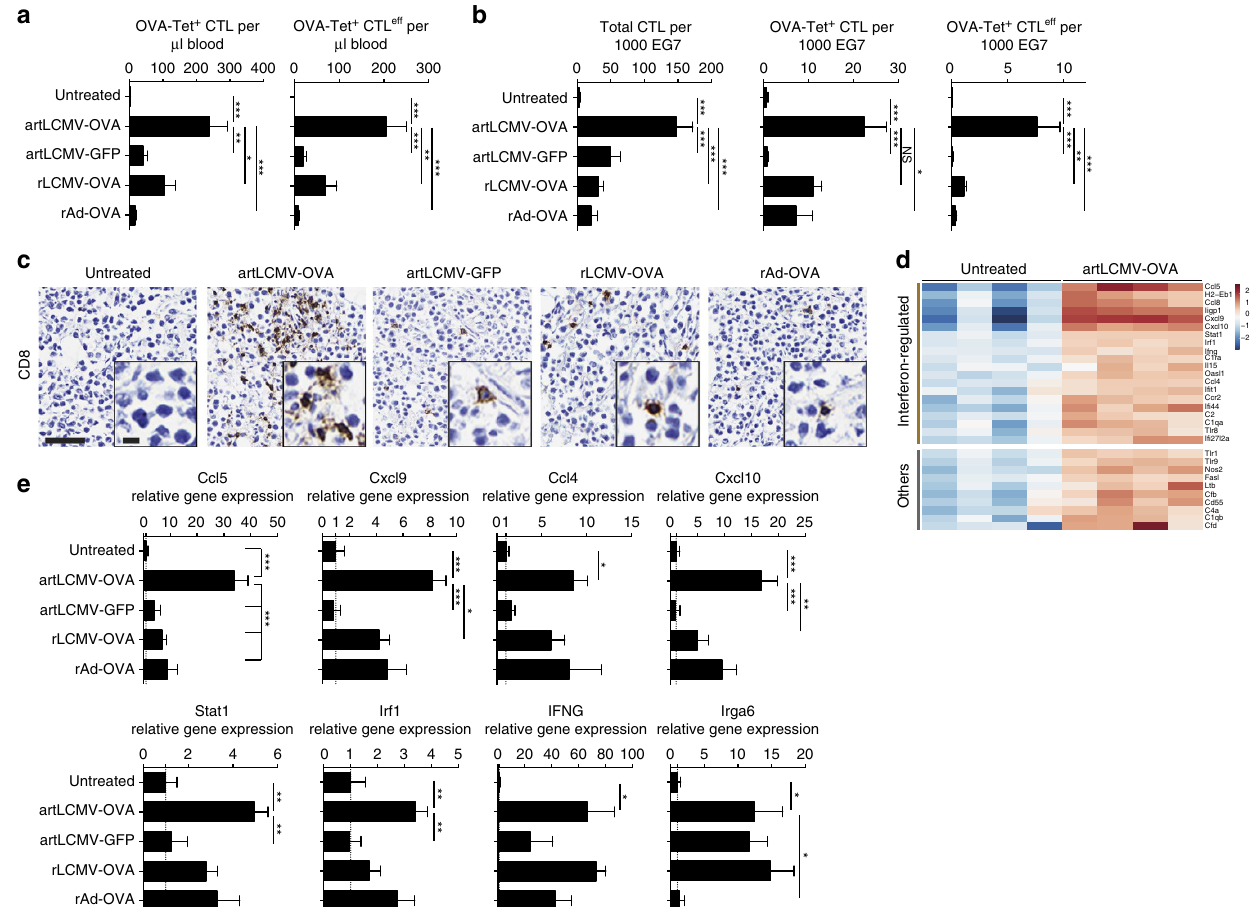
Figure 7 | artLCMV immunotherapy leads to CTL infiltration and inflammatory conversion of the tumour. ( a – e ) We implanted EG7-OVA tumour cells subcutaneously into the flank of C57BL/6 mice. On day 7, when tumours became palpable, we treated them with artLCMV-OVA, artLCMV-GFP, rLCMV-OVA, rAd-OVA or left them untreated. Peripheral blood ( a ) and tumour tissue ( b – e ) were analysed on d8 and d9 after treatment, respectively. We enumerated OVA-tetramer-binding total CTLs and CTL eff (Klrg1 þ ) in blood ( a ) and tumour ( b ) as indicated. CTLs were gated as live CD8 þ CD4 (cid:2) CD3 þ B220 (cid:2) lymphocytes. For normalization to EG7 tumour cells the latter were differentiated from infiltrating inflammatory cells by size and granularity. CTL eff were identified as Klrg1 þ . Bars represent the mean þ s.e.m. of five (artLCMV-OVA) or four mice (all other groups). N ¼ 2. ( c ) Tumours from mice as in a , b were analysed for infiltrating CD8 þ cells by immunohistochemistry. Representative pictures from four to five mice as in b are shown. Scale bars 10 m m (inset) and 100 m m (overview). N ¼ 2. ( d ) Gene expression profiles of inflammation-associated genes from tumour tissue of untreated or artLCMV-OVA-treated animals as in a – c by Nanostring technology. Differentially expressed genes (fold change Z 2, adjusted P value o 0.05) are displayed. Each lane represents a tumour from an individual mouse. Interferon-regulated genes are indicated according to www.interferome.org. ( e ) TaqMan RT-PCR validation of select genes identified in d . Bars represent the mean þ s.e.m. of 4–5 mice as in b . Data in a , b and e were analysed by one-way ANOVA with Dunnett’s post hoc test. NS, not significant; * P o 0.05, ** P o 0.01 and *** P o